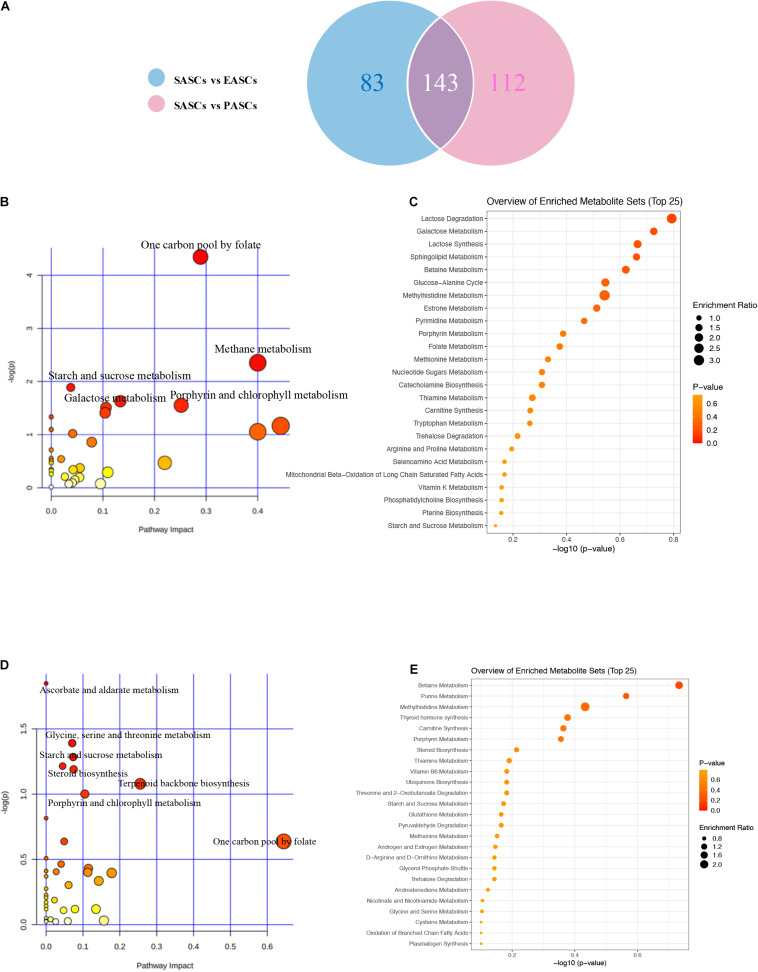
Analysis of unique differential metabolites in SASCs, EASCs, and PASCs. (A) A Wayne chart of differential metabolites between SASCs vs. EASCs with SASCs vs. PASCs. (B) Analysis of metabolic pathways of unique differential metabolites between SASCs and EASCs. (C) Overview of the enrichment of unique differential metabolites between SASCs and EASCs. (D) Analysis of metabolic pathways of unique differential metabolites between SASCs and PASCs. (E) Overview of the enrichment of unique differential metabolites between SASCs and PASCs.